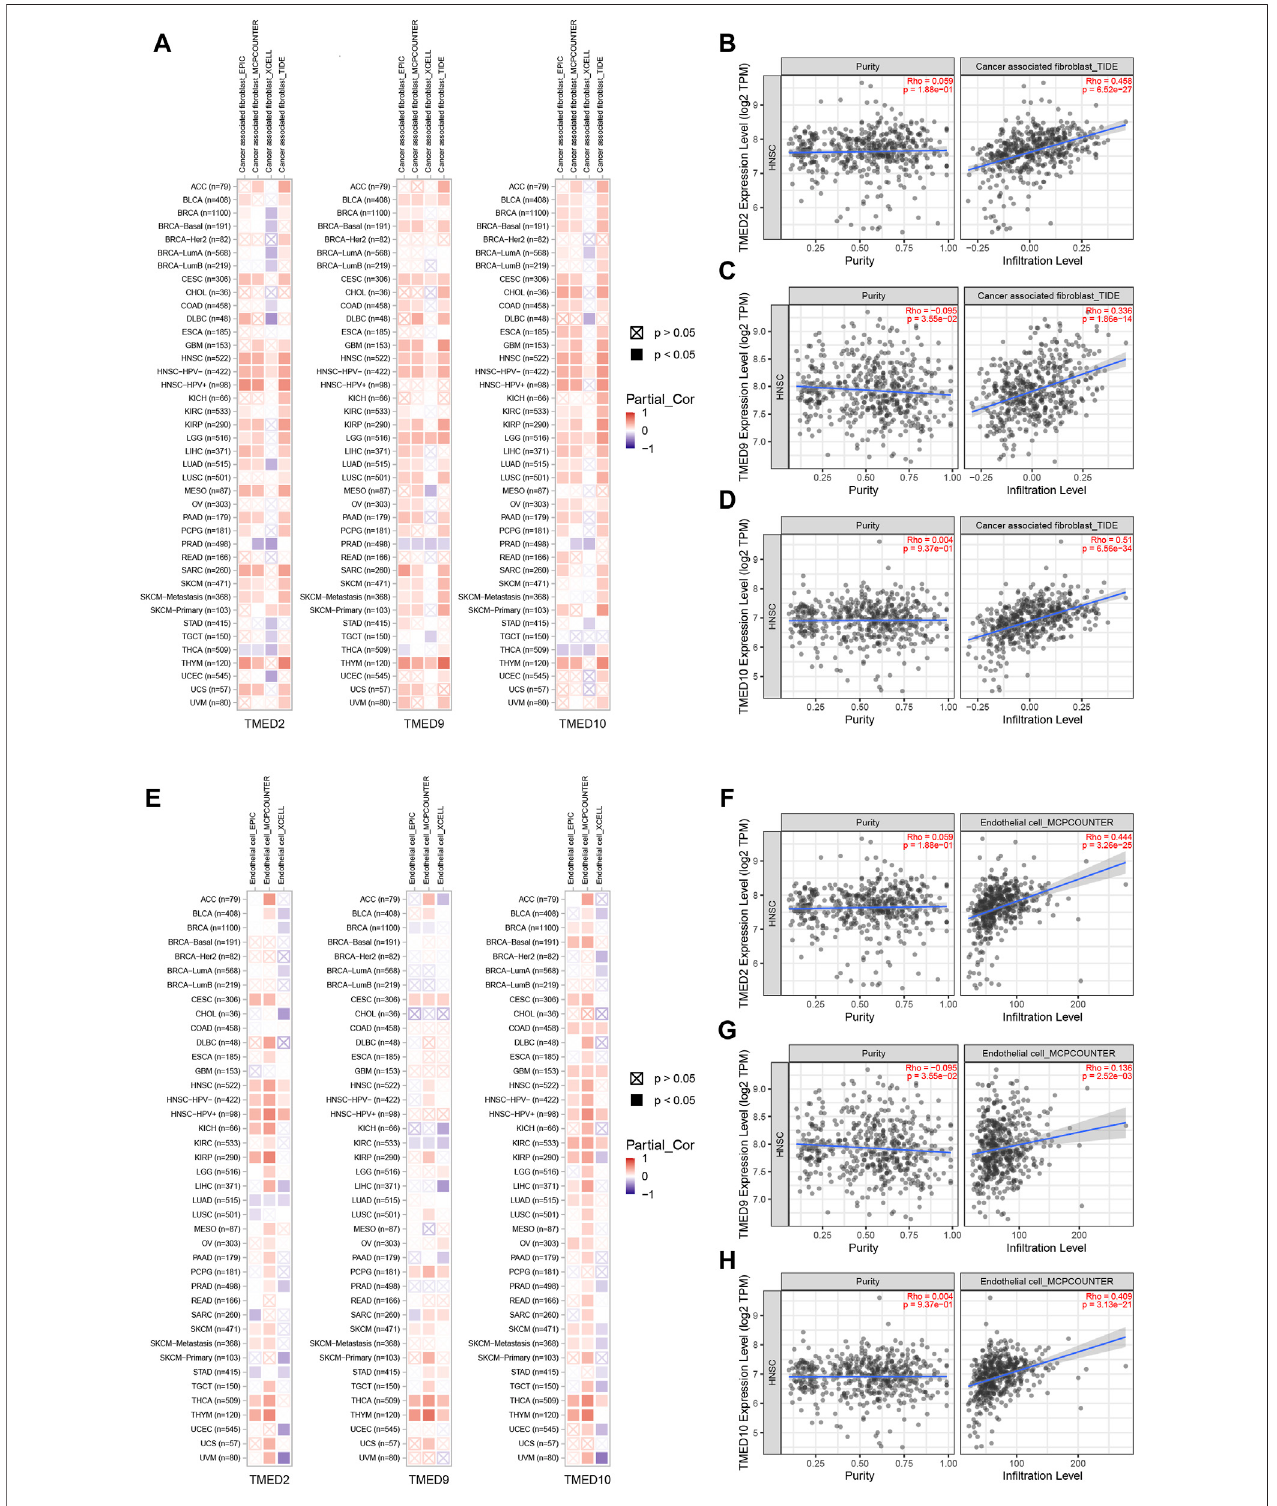
FIGURE 8 | Correlation of TMED2/9/10 expression with immune in fi ltration levels in HNSC. (A – D) TMED2/9/10 expression was signi fi cantly positively related to in fi ltrating levels of cancer-associated fi broblast. (E – H) TMED2/9/10 expression had signi fi cant positive correlations with in fi ltrating levels of the endothelial cells.